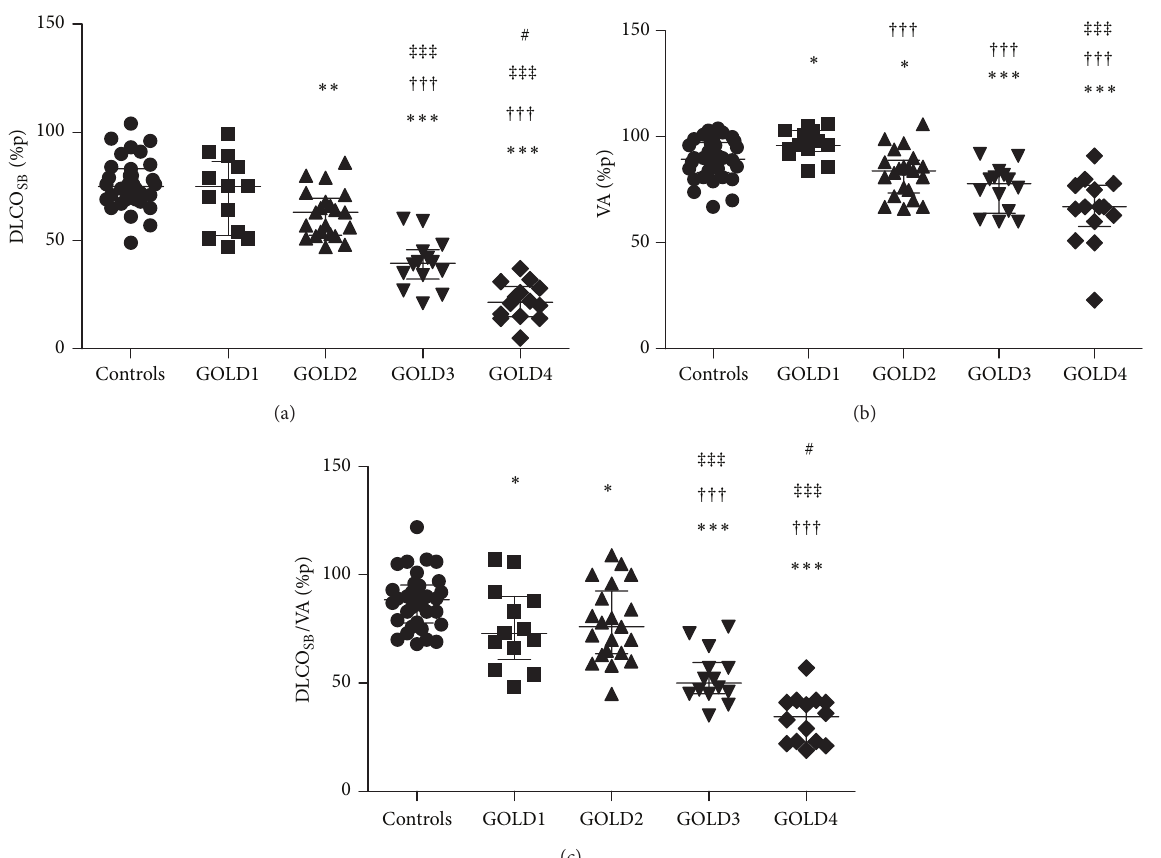
/ VA%p (c) measured by single breath helium dilution with CO-diffusion in controls Figure 2: DLCO SB %p (a), VA%p (b), and DLCO SB (healthy smokers) and COPD patients with GOLD stage 1–4. ∗ Significant difference compared to healthy smokers, † significant difference compared to GOLD1, ‡ significant difference compared to GOLD2, # significant difference compared to GOLD3, one symbol flagging 𝑃 < 0.05 , two symbols flagging 𝑃 < 0.01 , and three symbols flagging 𝑃 < 0.001 . Data are presented as individual dots together with median with interquartile